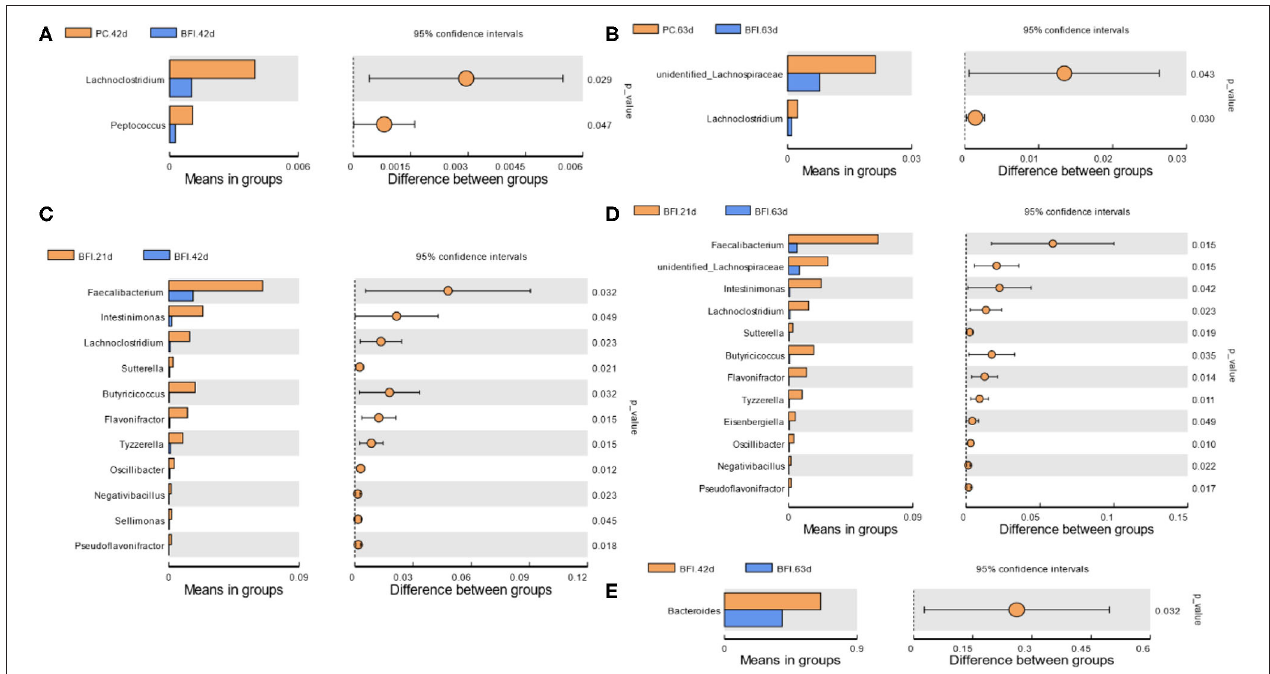
FIGURE 4 | T-test analysis for the significant changes of differential microbiota at genus level in the cecal contents of yellow-feathered broilers. NC, negative control without in-feed antibiotics. PC, positive control with in-feed antibiotics with 200 mg/kg of oxytetracycline calcium + 250 mg/kg of nasiheptide. BFI, compound probiotics consisting of heat-inactivated Bacillus subtilis and Lactobacillus acidophilus BFI. (A) PC. 42 d vs. BFI 42 d. (B) PC. 63 d vs. BFI 63 d. (C) BFI. 21 d vs. BFI 42 d. (D) BFI. 21 d vs. BFI 63 d. (E) BFI. 42 d vs. BFI 63